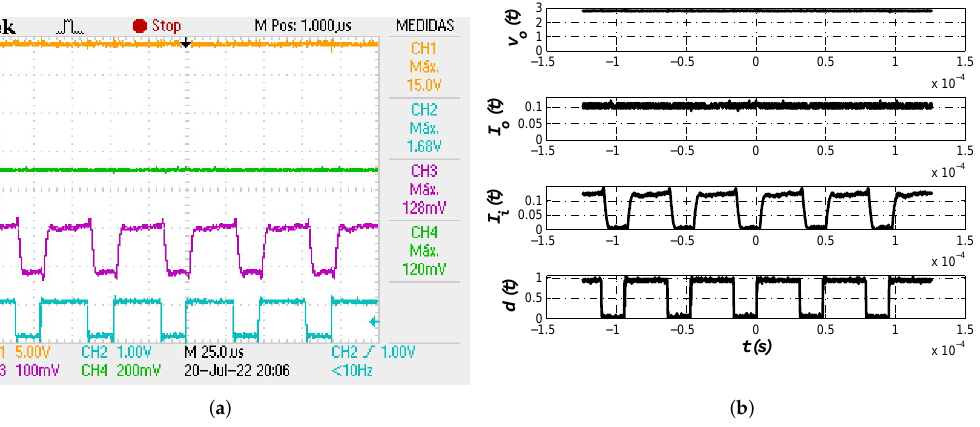
Figure 14. ( a ) Oscilloscope view for measurements of output voltage v o ( t ) (yellow), output current I o ( t ) (green), input current I i ( t ) (purple) and PWM signal d ( t ) (cyan). ( b ) Alternative view of exported experimental data preserving scale of 5 V/unit for v o ( t ) , 100 mV/unit for I o ( t ) and I i ( t ) . Second test performed over the implemented circuit was output regulation in the presence of load variation, for which the value of resistance was changed from R o = 10 Ω to R 1 = 45 Ω . The objective is to determine controller approximation’s effectiveness of keeping the voltage level at the reference value. Figure 15 shows the evolution of output voltage v o ( t ) and load current I o ( t ) in the presence of load variation. Efficiency of proposed approach to return the output voltage to reference level was corroborated, since it took the controller about 1 ms to restore the voltage level.